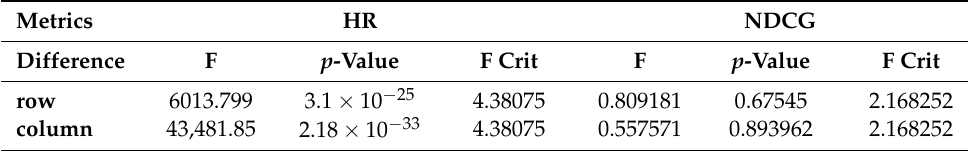
Table 2. The results of statistical significance tests with HR and NDCG on MovieLens.